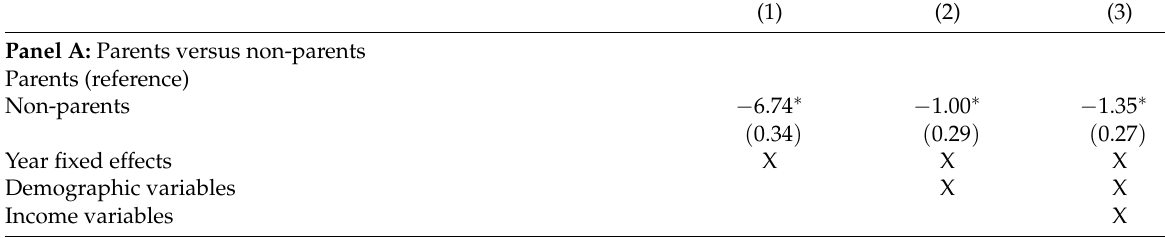
Table 2: Regressions of percentile net worth, by household type ( N = 41,